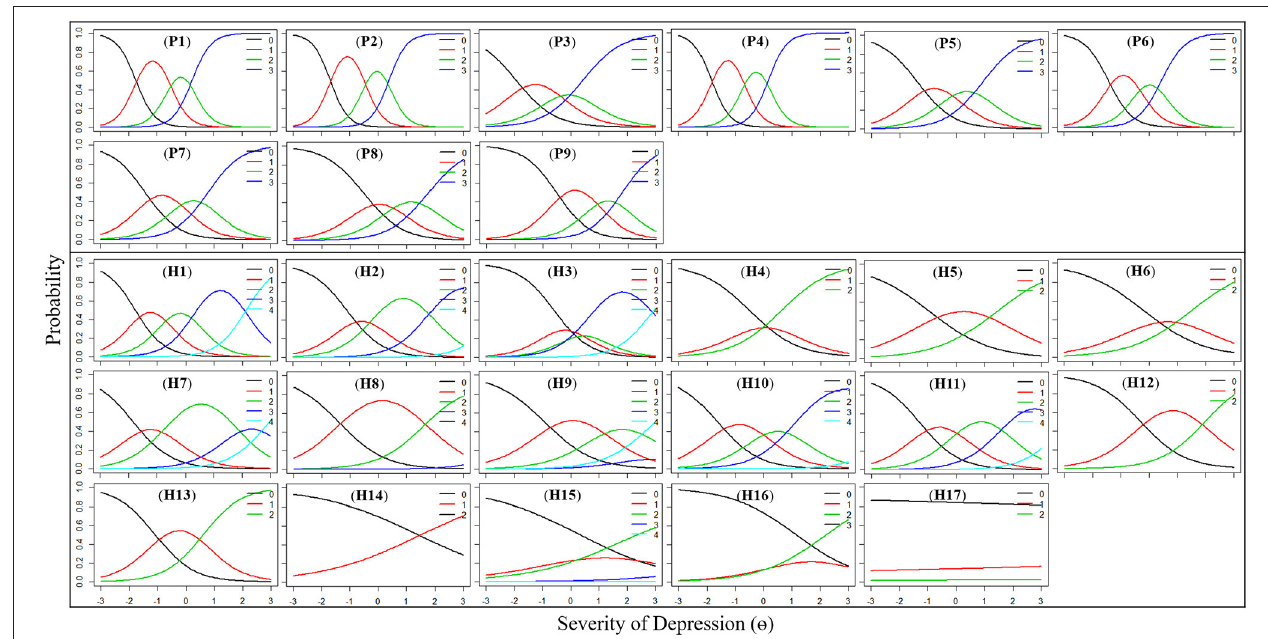
FIGURE 1 | Category characteristics curves for the PHQ-9 and HAMD-17